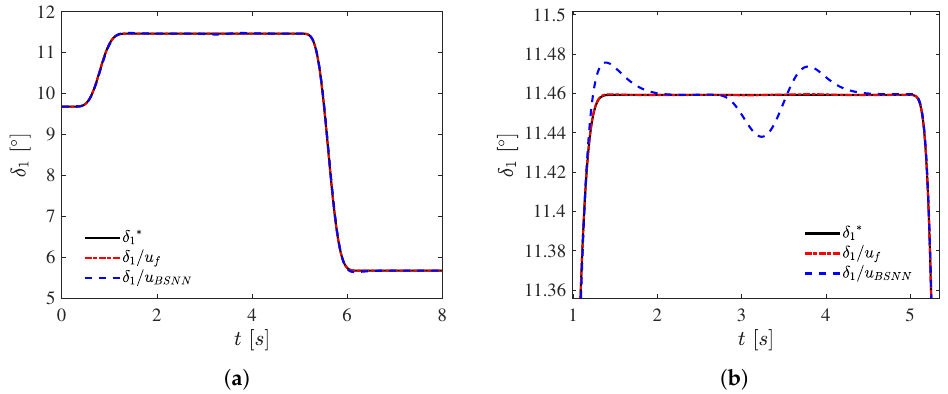
Figure 7. Load angle of generator 1 of two interconnected power systems: ( a ) δ 1 ; ( b ) zoom of δ 1 .